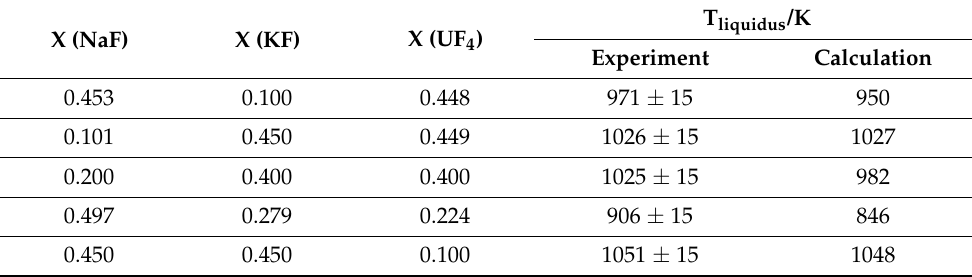
Table 5. Experimentally determined liquidus equilibria of the NaF-KF-UF 4 pseudo-ternary system obtained by DSC and calculated liquidus temperatures at these compositions for